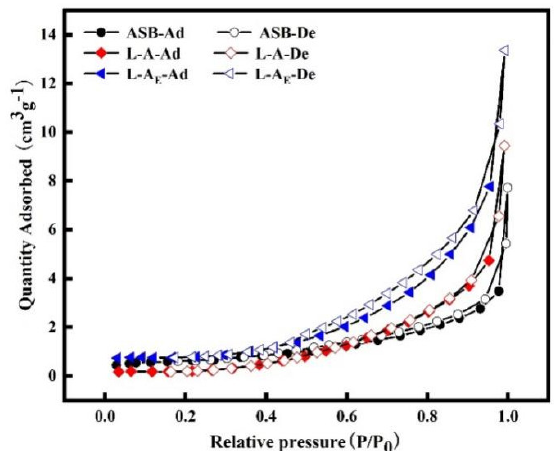
Figure 6. N 2 adsorption–desorption isotherms of the materials.